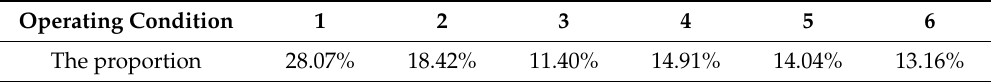
Figure 8. The operating condition of the mission profile experienced by the latter 1/3 data. Table 6. The proportion of each operating condition under the mission profile experienced by the latter 1/3 data.